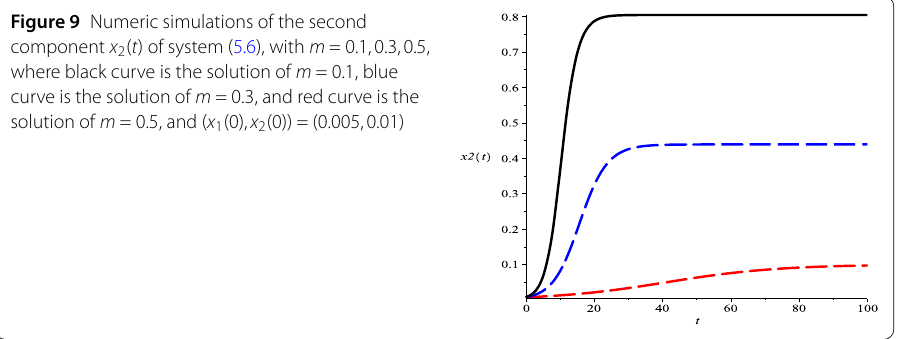
Figure 9 Numeric simulations of the second component x 2 ( t ) of system (5.6), with m = 0.1,0.3,0.5, where black curve is the solution of m = 0.1, blue curve is the solution of m = 0.3, and red curve is the solution of m = 0.5, and ( x 1 (0), x 2 (0)) =